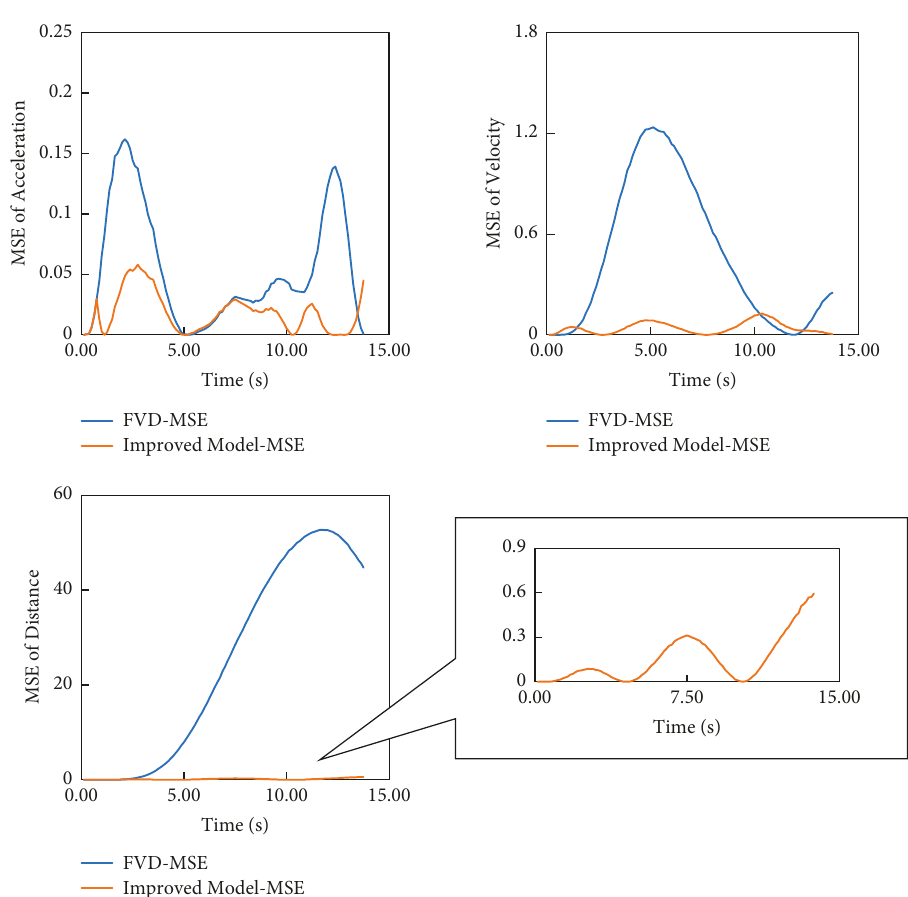
Figure 11: The curves of a subject vehicle’s acceleration, speed, and distance in a car-bus